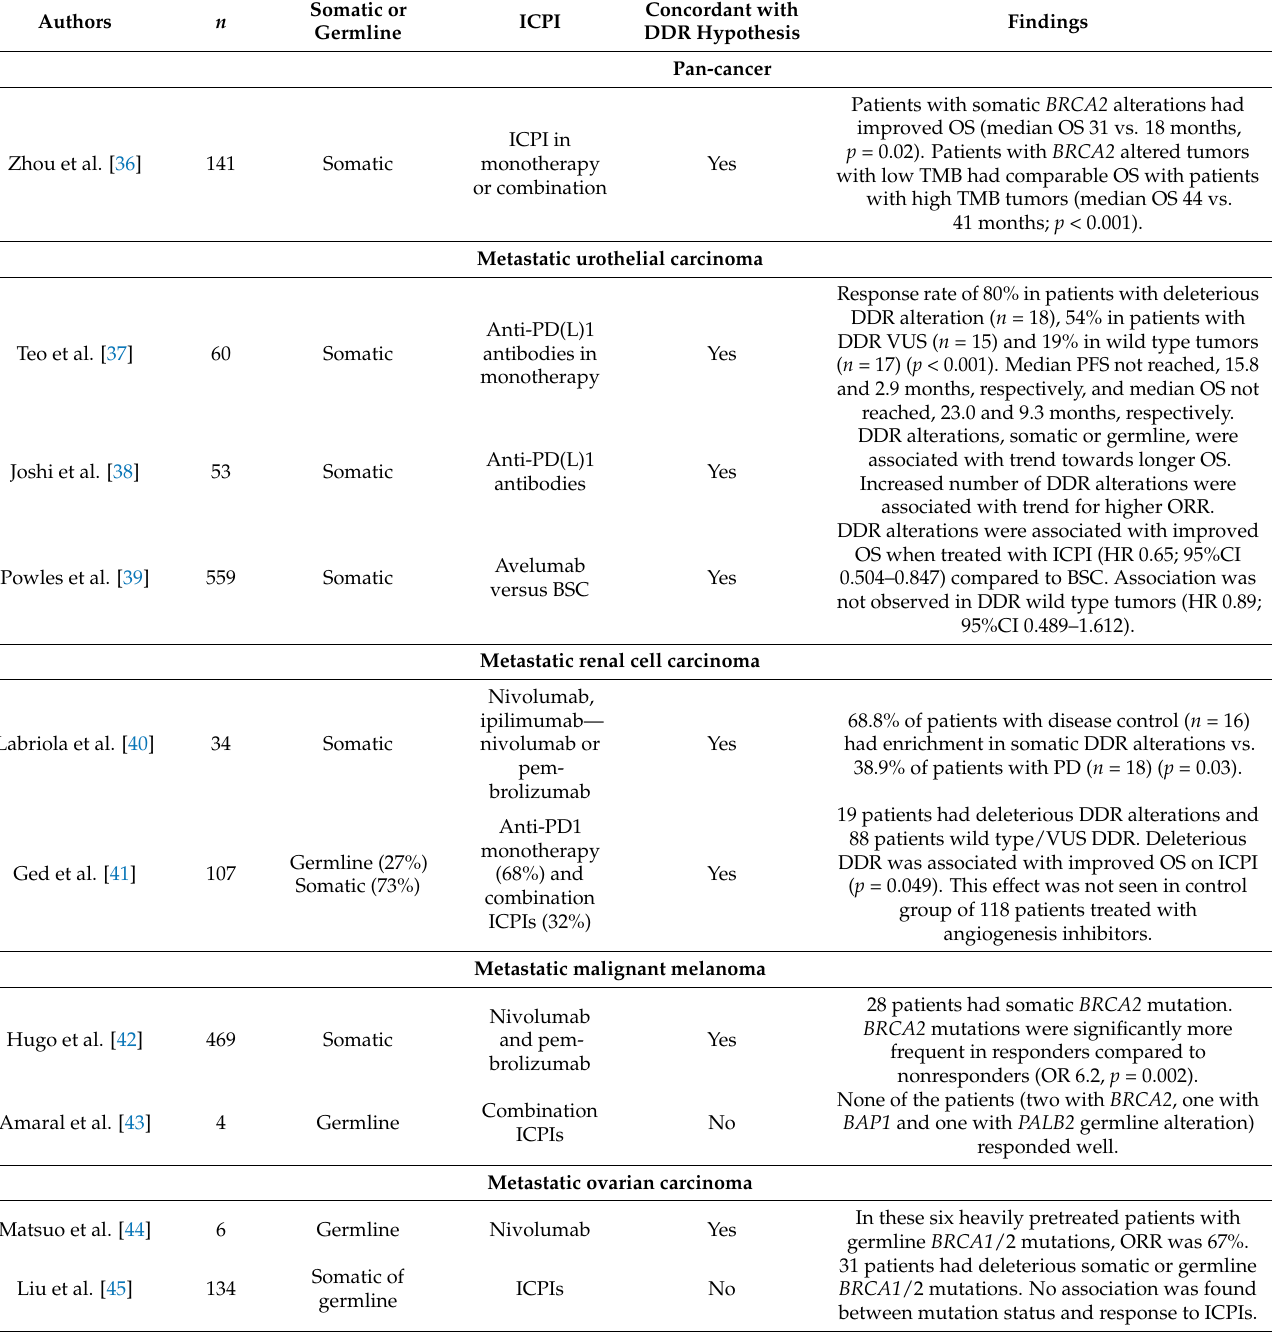
Table 4. Literature evidence regarding the effect of DDR disease-associated variants on the response to ICPIs.